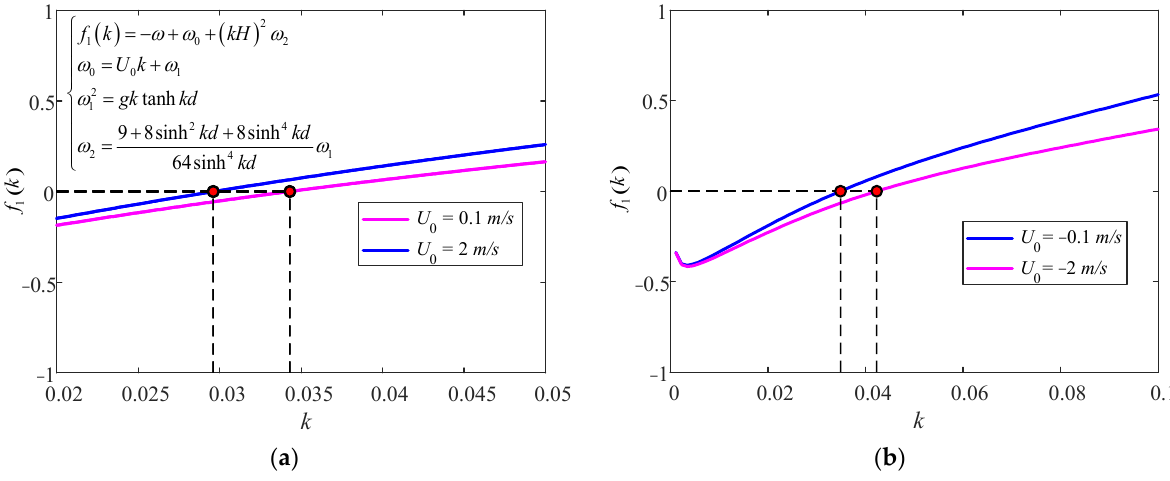
Figure 6. Wave number k ( a ) in a following current and ( b ) in an opposing current.